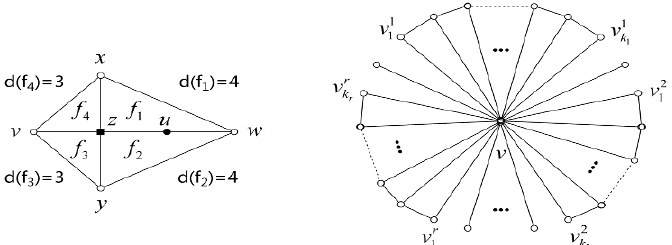
Figure 2. Some relative definitions to the proofs of the main theorems